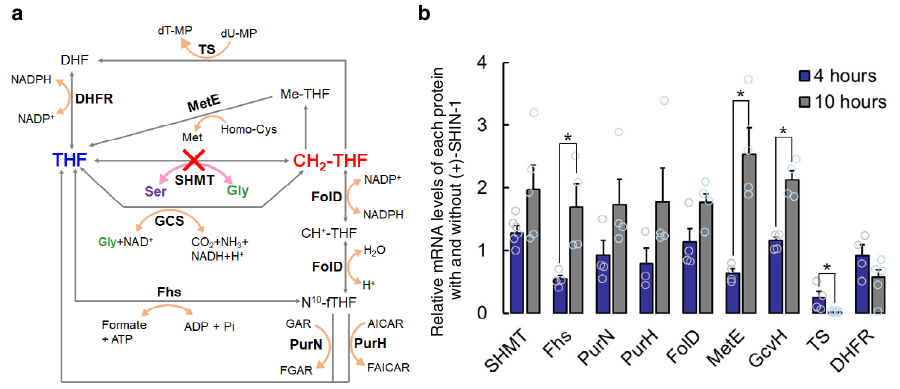
Fig. 3 The postulated folate cycle in E. faecium and changes in mRNA levels of folate-binding proteins upon addition of ( + )-SHIN-1. a E. faecium genome [Genbank code: UFYJ01000001.1] codes for several proteins related to the folate cycle. GCS and Fhs may support production of THF and CH 2 -THF under SHMT-inhibition conditions. b The relative mRNA expression levels of each folate-binding protein with and without ( + )-SHIN-1. Four hours after adding 2 μ M ( + )-SHIN-1, mRNAs for expression of SHMT and GcvH increased and those of Fhs, MetE and TS decreased. In contrast, 10h after adding 2 μ M ( + )-SHIN-1, mRNA expression levels of folate-binding proteins, except TS and DHFR, tended to increase. Open circles are the values for calculating the average values and standard error ( n = 4). For SHMT at 4 and 10h, the n number is six ( n = 6) and fi ve ( n = 5) respectively. For PurH at 4 h, the n number is three ( n = 3). * Asterisk means p -value< 0.05 ( P = 0.01 for Fhs and GcvH, and P = 0.04 for MetE and TS) For DHFR at 10h, the n number is fi ve. TS thymidylate synthetase, DHFR dihydrofolate reductase, GCS glycine cleavage system, MetE cobalamin-independent methionine synthase, Fhs formyltetrahydrofolate synthetase, FolD 5,10-methylene tetrahydrofolate dehydrogenase, PurN glycinamide-RNase-transformylase N, GAR glycinamide ribonucleotide, FGAR formyl glycinamide ribonucleotide, PurH AICAR transformylase, AICAR 5-amino-4-imidazole carboxamide ribotide, FAICAR 5- formamidoimidazole-4-carboxamide ribonucleotide, GcvH glycine cleavage system H